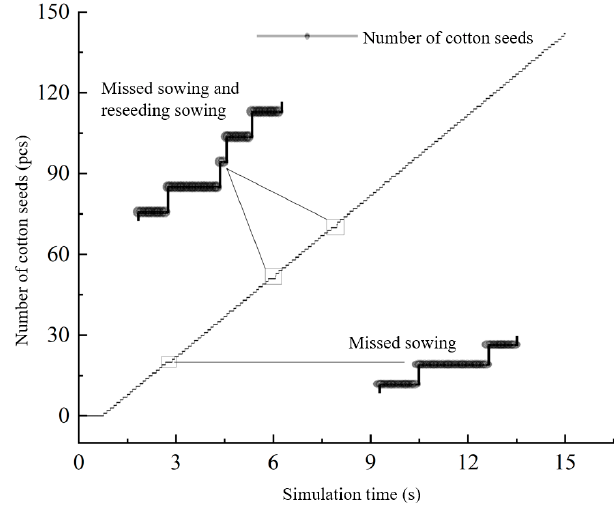
Figure 15. Seeding performance analysis curve.